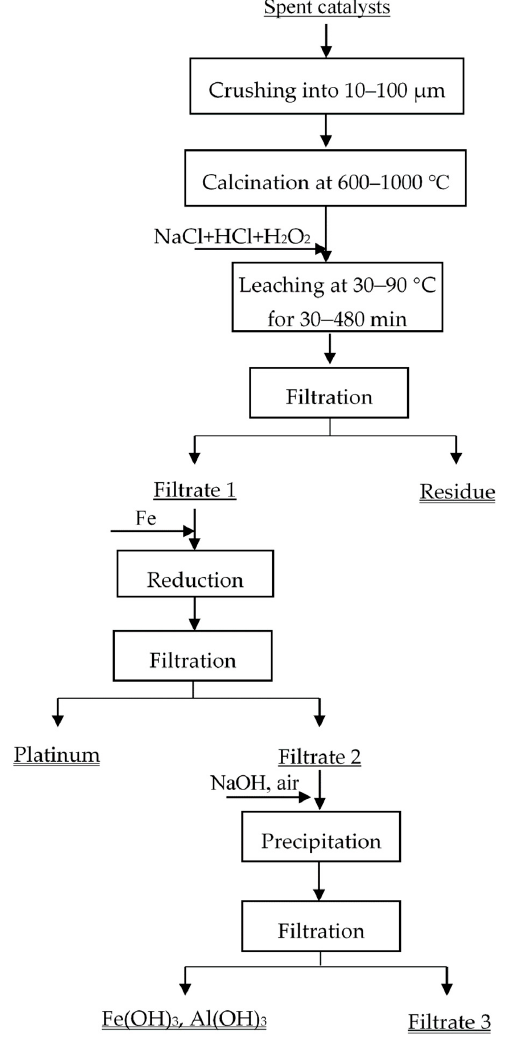
Figure 2. The process of platinum recycling from spent petroleum catalysts.